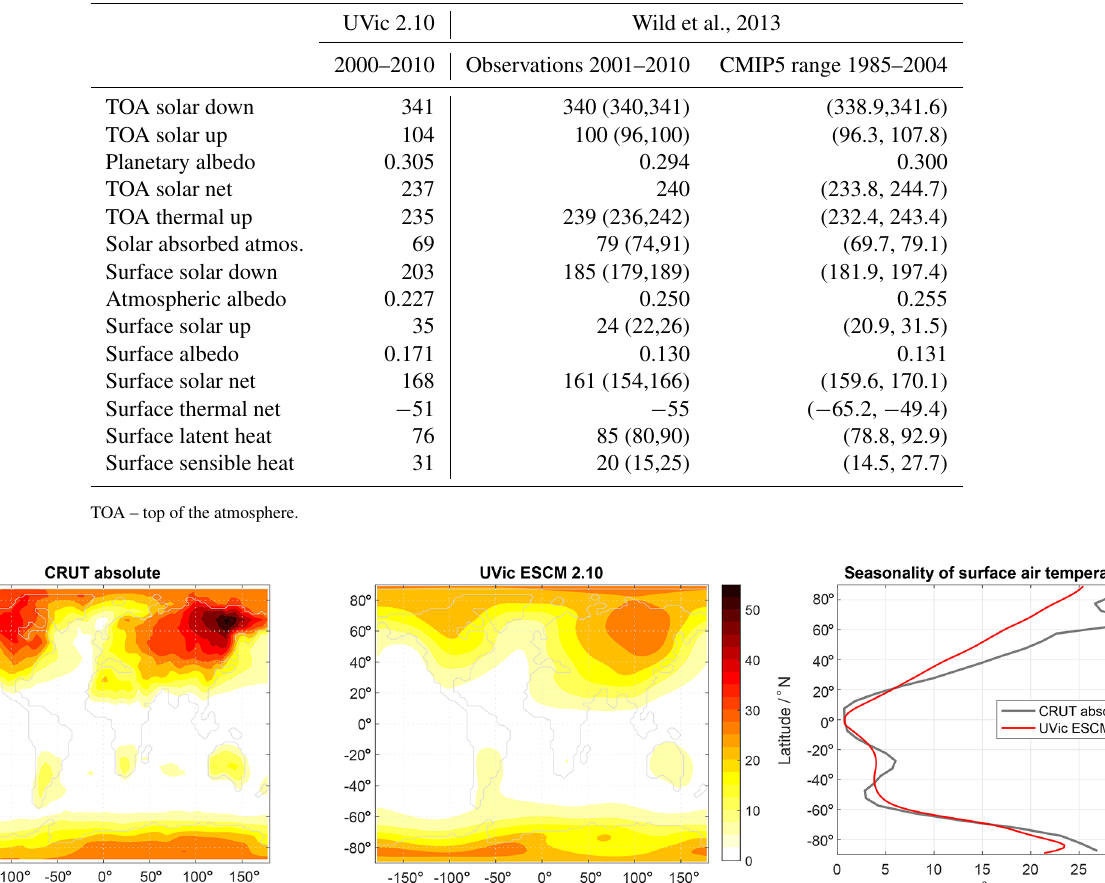
Table 3. Global radiation balance of the UVic ESCM 2.10 in comparison with Wild et al. (2013). Unitless albedo values and radiation fluxes (in Wm − 2 ) are